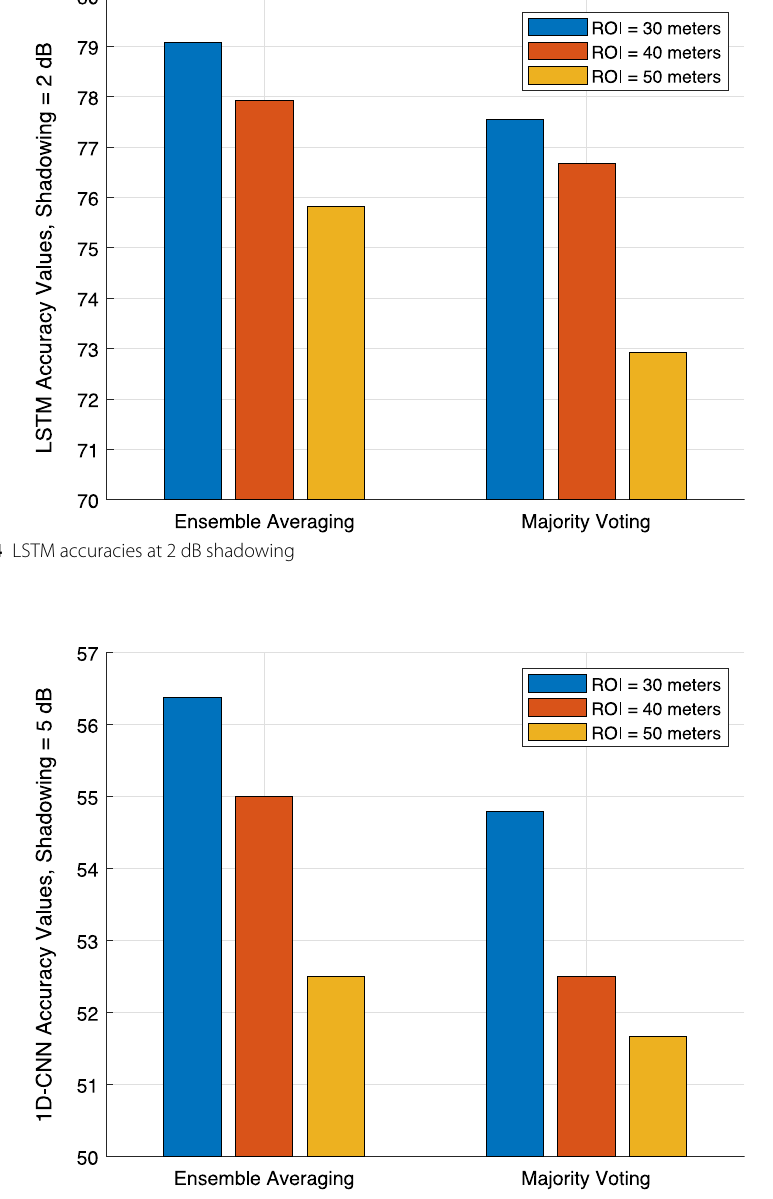
Fig. 5 1D CNN accuracies at 5 dB